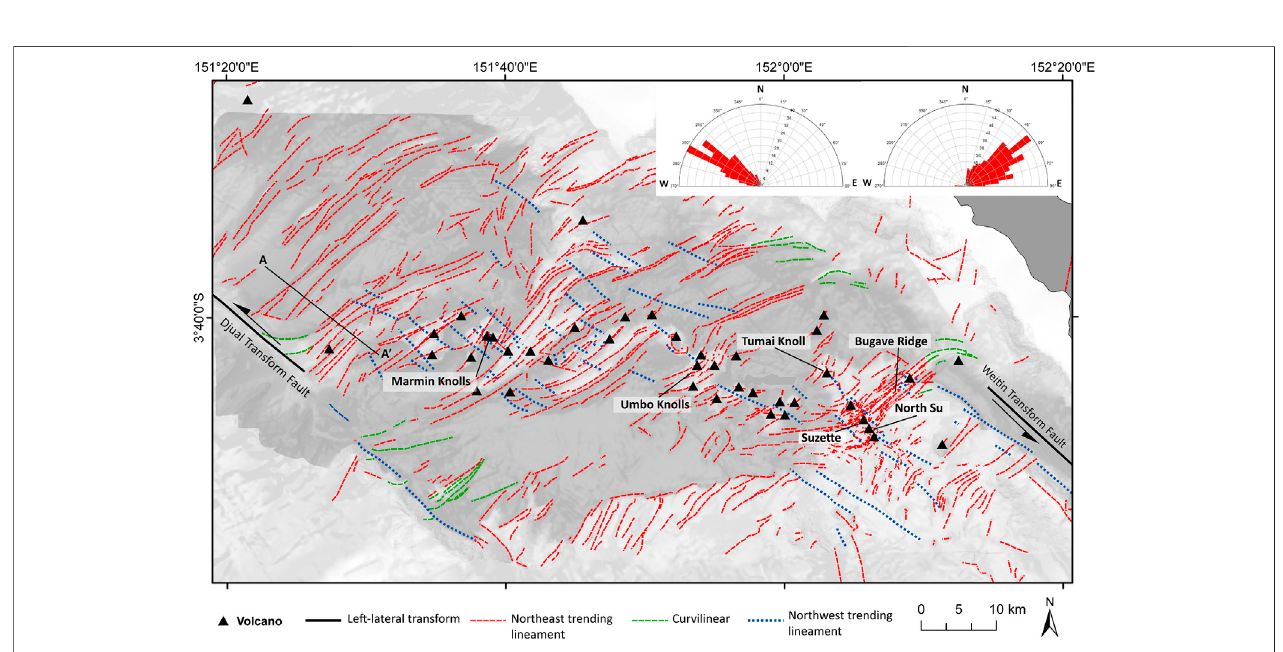
FIGURE7| LineamentanalysisoftheEMB.Lineamentsareseparatedintofourgroups:left-lateraltransforms(themajorstructures);northeast-trending;curvilinear (arcuate curved appearance); and northwest-trending. Lineament terminology isbased on current structuralinterpretations described for thegreaterManusBasin (e.g., Martinez and Taylor, 1996; Sinton et al., 2003). Black triangles identify the location of known volcanoes. Lineament orientation distribution shown in the inset.